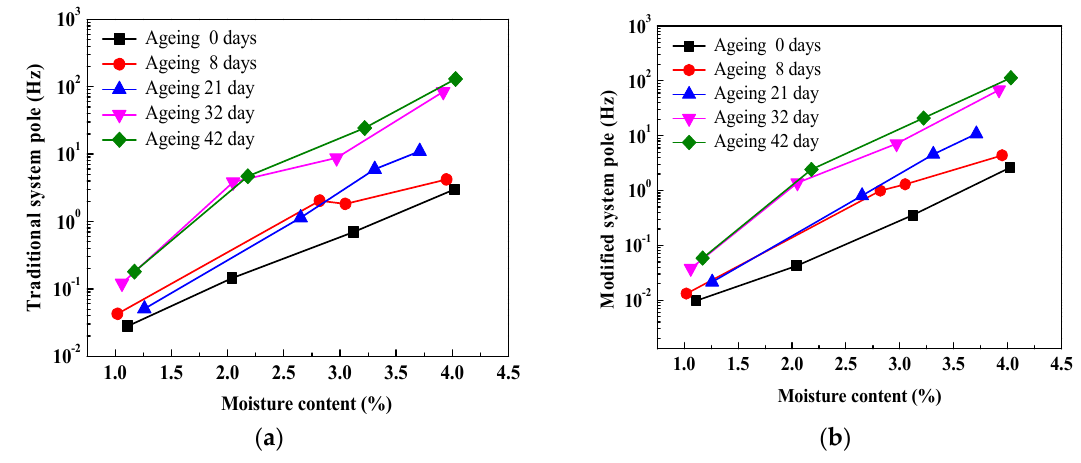
Figure 13. Comparisons of relationships between system poles and moisture content. ( a ) Traditional system poles; ( b ) modified system poles.